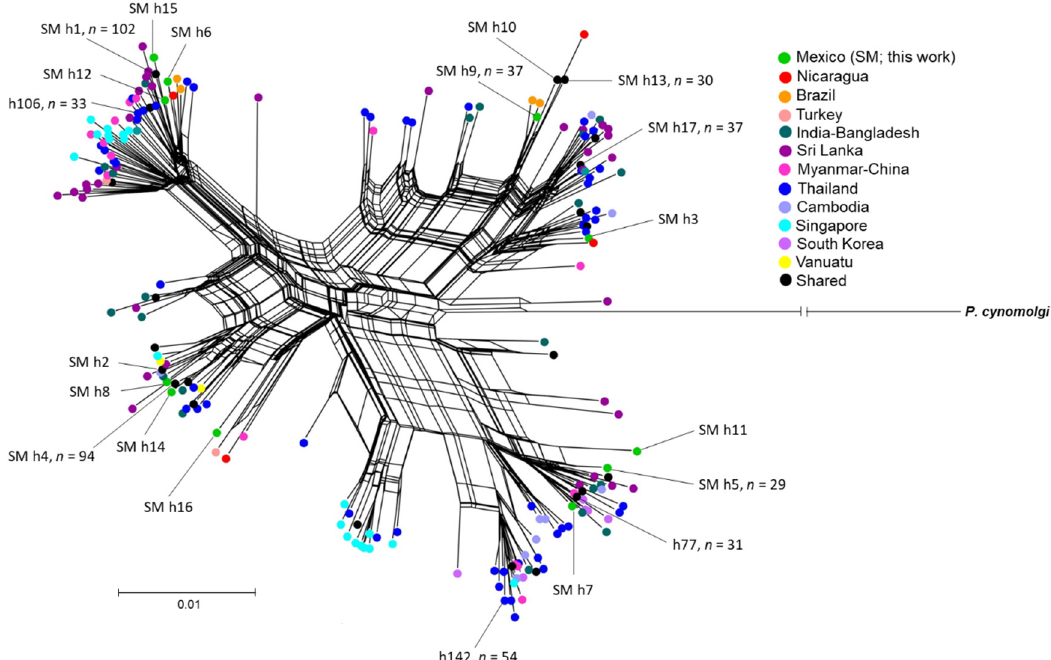
Figure 5. SplitsTree analysis of the global distribution of P. vivax msp1 42 . The four main clusters found with the NeighborNet method resembled haplogroups A, B, C, and D (established by the haplotype network). Only the most common worldwide haplotypes ( ≥ 29) and those from this study are portrayed. P. cynomolgi served as the outgroup. The bar scale denotes the nucleotide substitution per site.